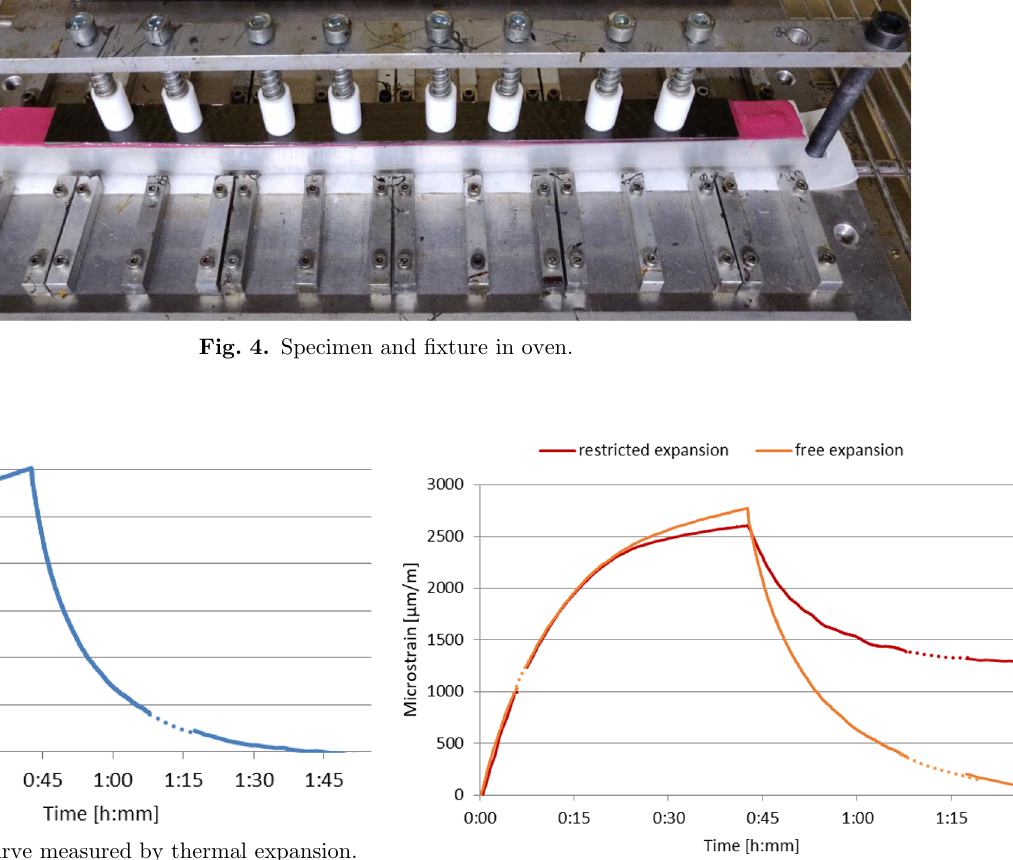
Fig. 6. Comparison between free expansion and restricted